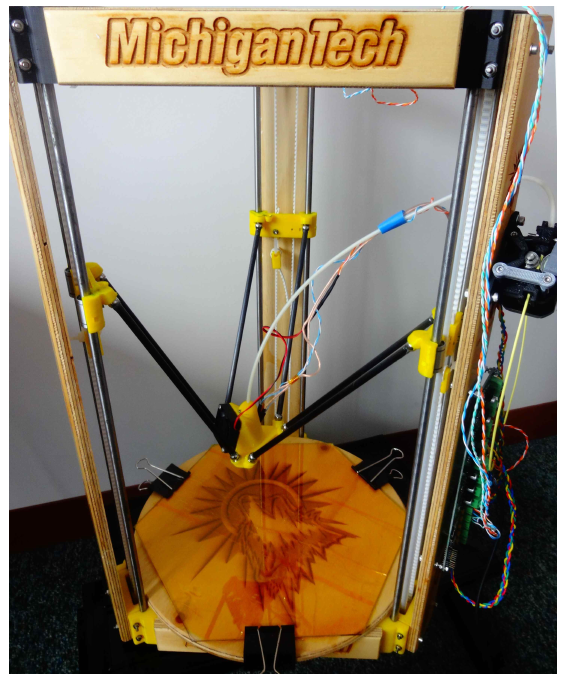
Figure 1. The MOST Delta RepRap 3-D printer. The yel- low and black polymer components of the 3-D printer have been printed on the same type of 3-D printer. The glass hexagon at the base is print